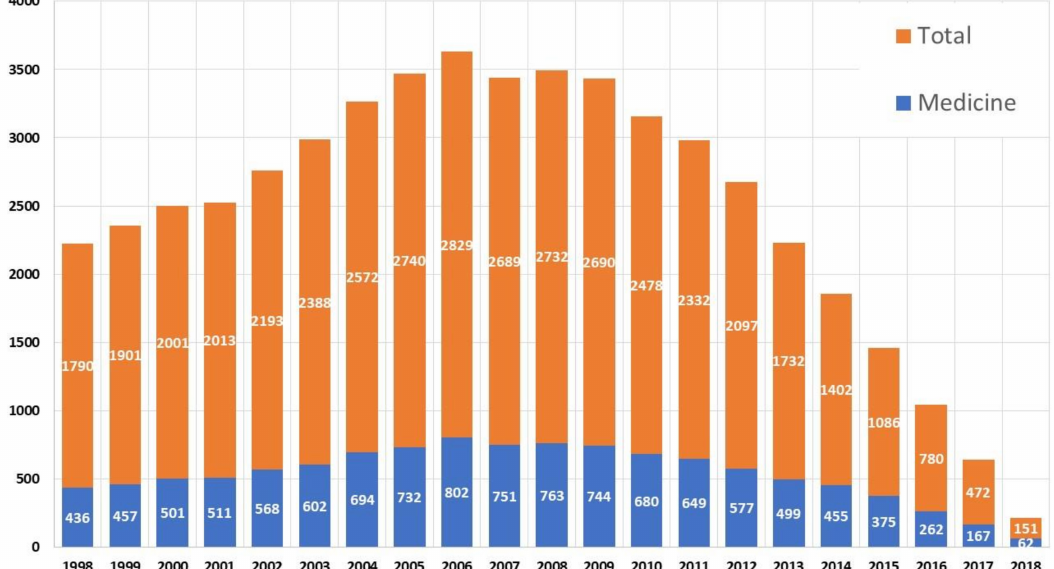
Figure 10. Medicine category display in relation to the total number of publications cited in